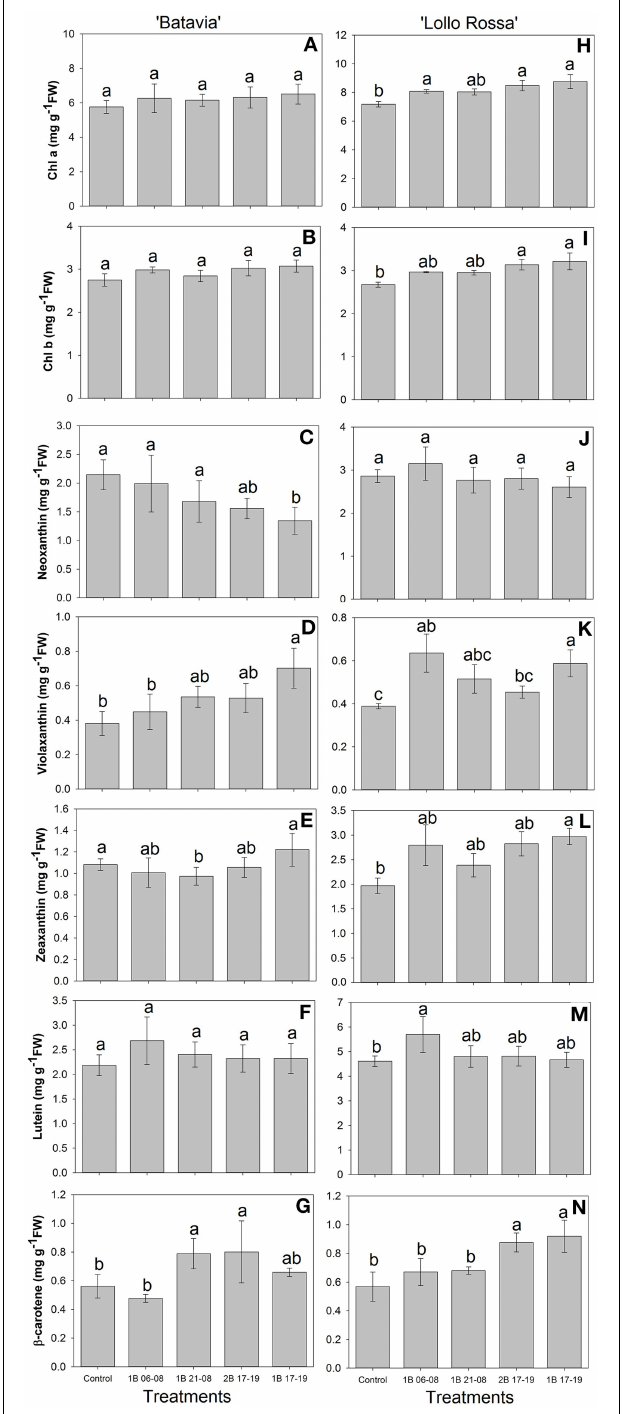
FIGURE 9 | Pigment content (chl a , chl b , neoxanthin, violaxanthin, zeaxanthin, lutein, β -carotene) of Lactuca sativa “Batavia” (A–G) and “Lollo Rossa” (H–N) grown under the five different LED treatments with the same abbreviations as in Figure 2. Data are mean values ( n = 4, four different leaves from different plants per treatment and cultivar) ± SE. Assignment of the same letters indicates values that are not significantly different at P -values < 0.05 within pigments and treatments.